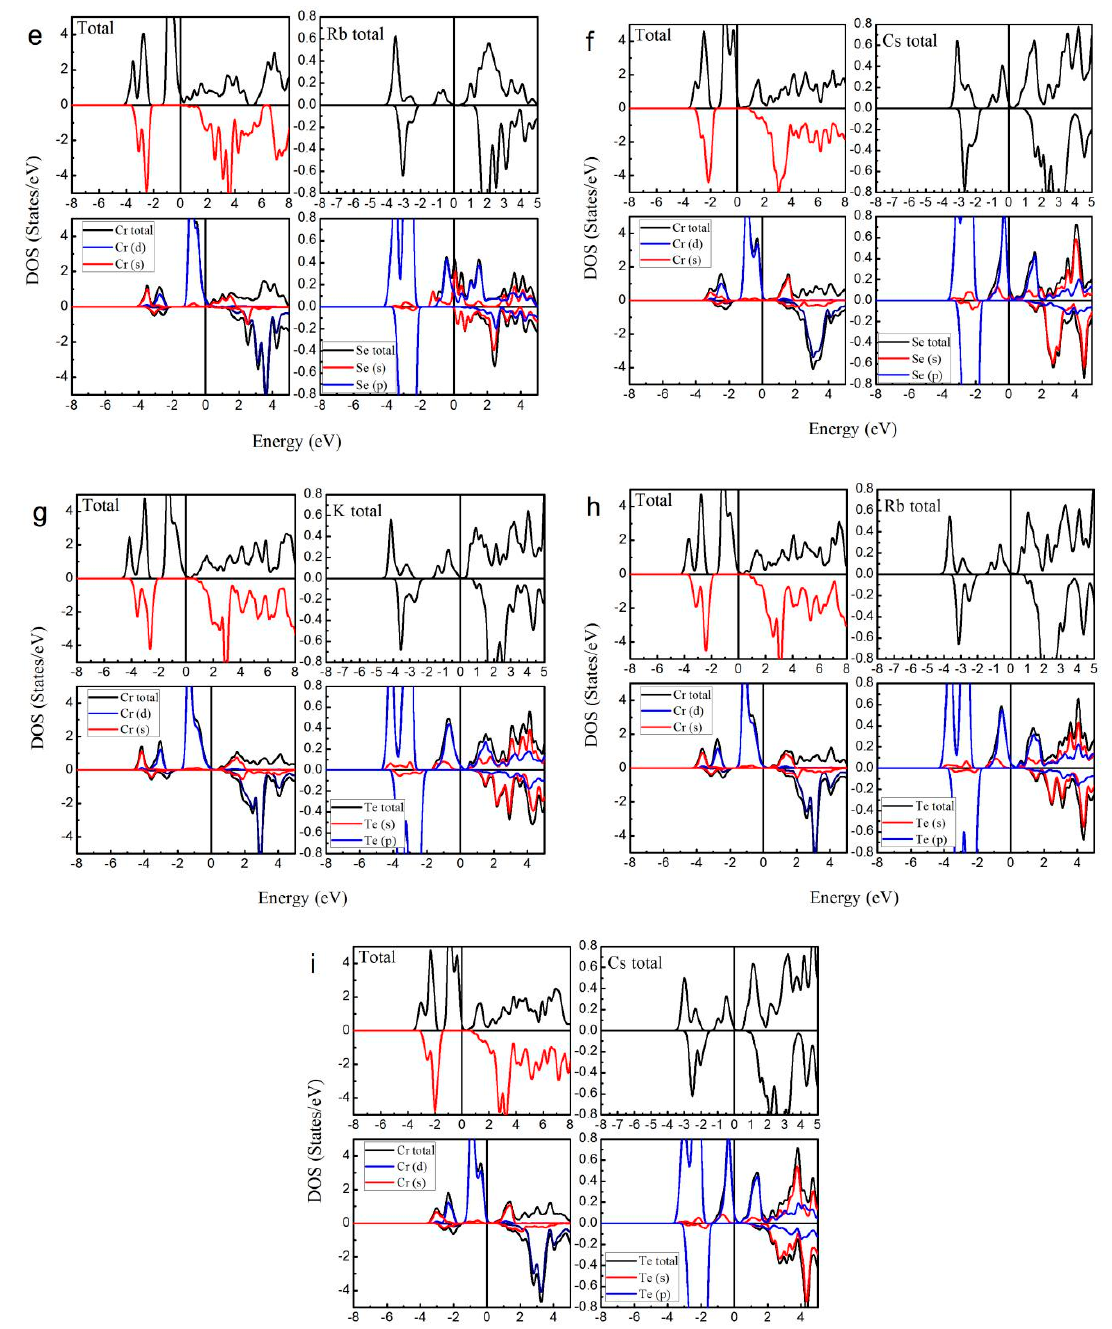
Figure 3. Calculated total and atom-projected density of states (DOS) for ( a ) type I KCrS; ( b ) type I RbCrS; ( c ) type I CsCrS; ( d ) type I KCrSe; ( e ) type I RbCrSe; ( f ) type III CsCrSe; ( g ) type III KCrTe; ( h ) type III RbCrTe; and ( i ) type III CsCrTe. (The Fermi level E F was set as X = 0).